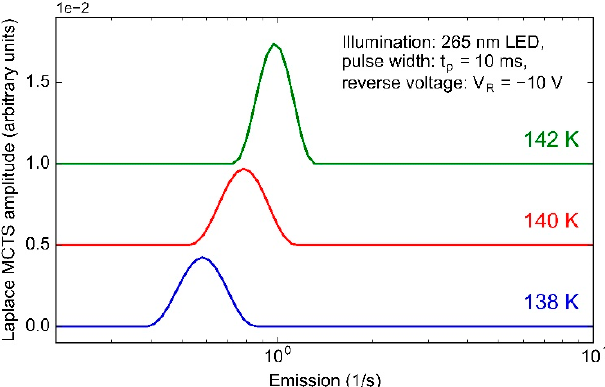
Figure 5. Laplace-MCTS spectra at several temperatures for the as-grown n -type 4H–SiC semi-transparent SBD. Measurement settings: sampling rate 5–8 kHz, number of samples 3 × 10 4 , and number of averaged transients 400.